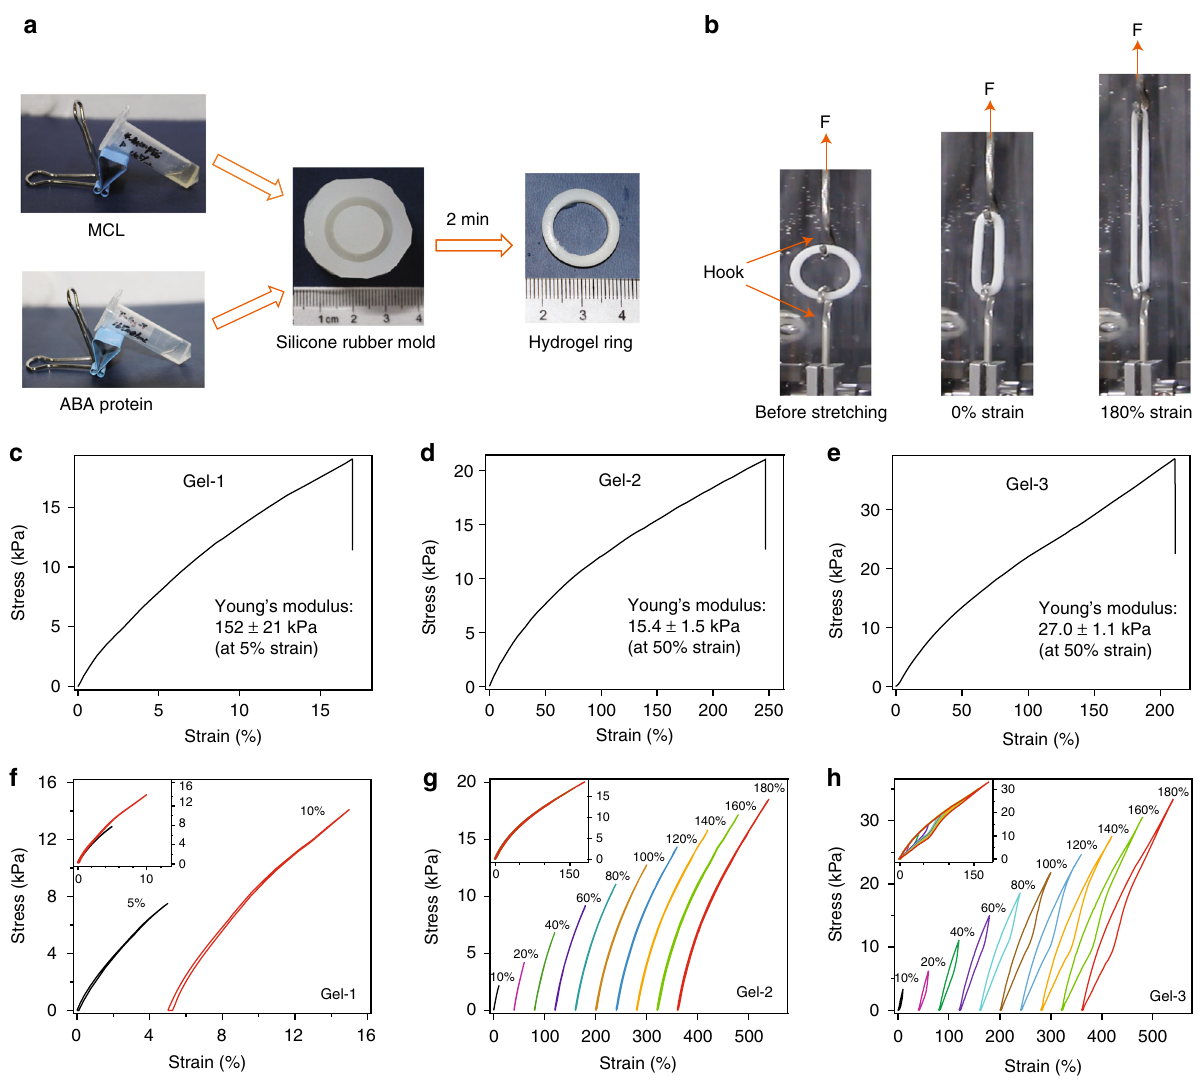
Fig. 3 The bulk mechanical properties of the designed hydrogels. a The general procedure to prepare the protein hydrogel rings for mechanical testing. All protein gels were cross-linked by TIP-1:Kir complexes. (GB1) 8 , (GB1-HP67) 4 and SH3 were used as the LBMs and the corresponding hydrogels were denoted as Gel-1, Gel-2 and Gel-3, respectively. b The setup for the mechanical tests of the ring-shaped hydrogel. c – e The stress – strain curves for Gel-1, Gel-2 and Gel-3 until break. The protein concentrations were 180 mg mL − 1 . f – h Representative stretching – relaxation curves for Gel-1, Gel-2 and Gel-3. The curves are horizontally offset for clarity. The fi nal strains are shown on the curves. Insets show the superposition of the stretching – relaxation curves at different